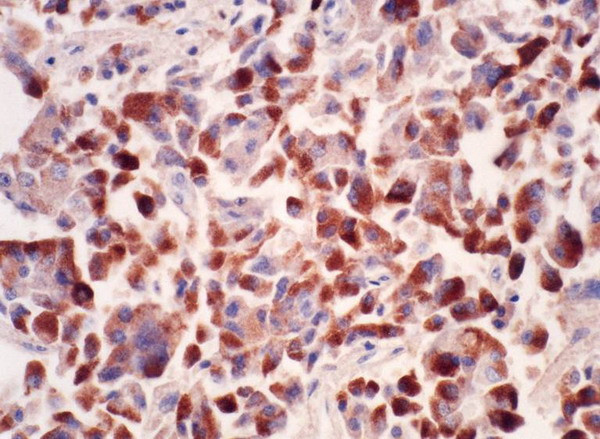
The tumor cells were strongly immunopositive for gastrin. (×250, avidin-biotin-peroxidase).